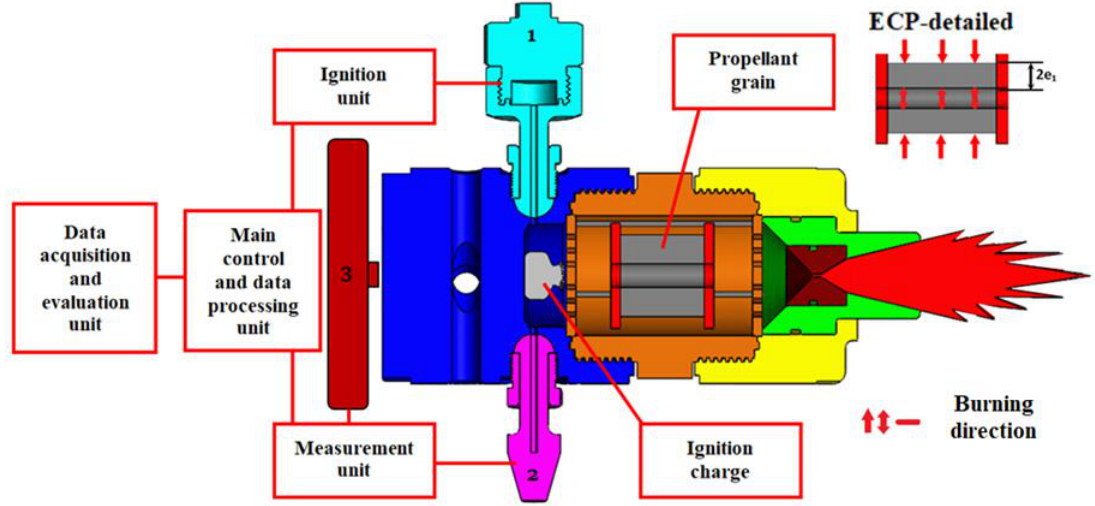
Figure 13. Subscale rocket motor set-up: ( 1 ) ignition; ( 2 ) pressure transducer; ( 3 ) thrust transducer (e 1 : burning propellant thickness).